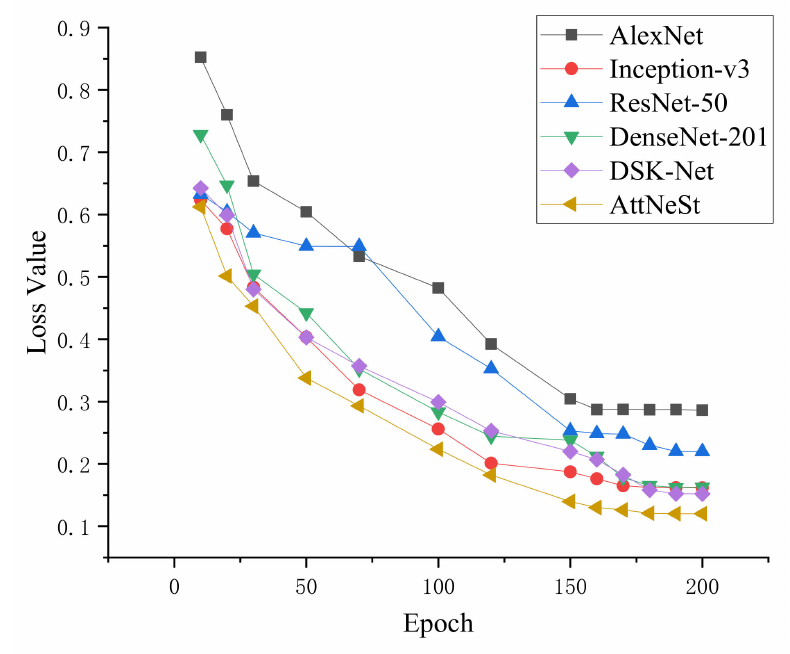
Figure 7. Loss variation by